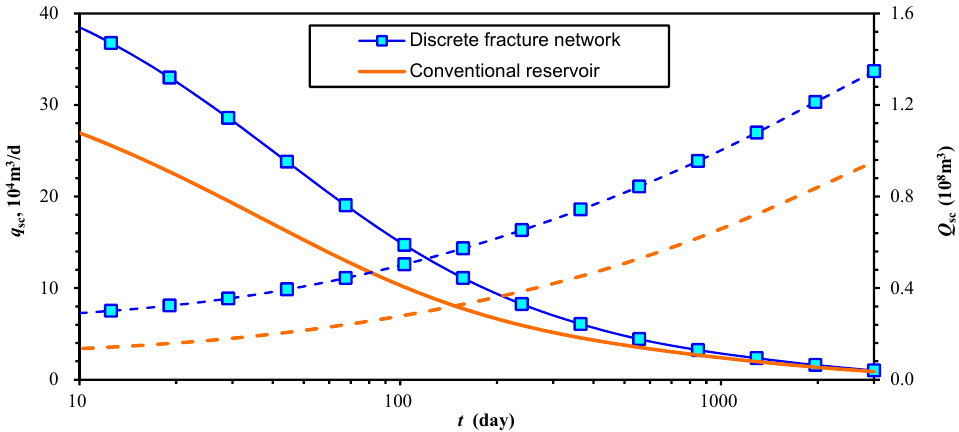
Figure 11. Curves of production rate and accumulative production of a multi-stage fractured horizontal well (MFHW) in shale.